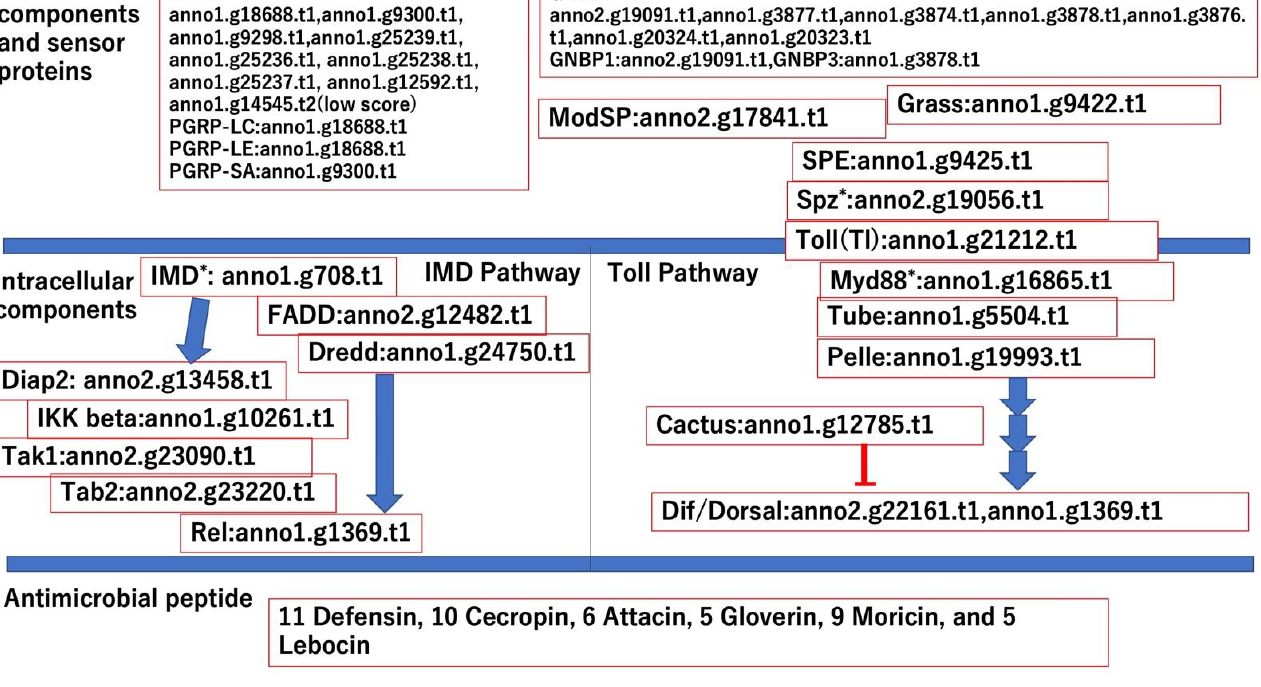
Figure 2. Gene IDs of the orthologues consisting of Toll and IMD pathway based on BLASTx search. The number of genes of antimicrobial peptides is shown in bottom of this figure, and the gene IDs of the orthologs of antimicrobial peptides are shown in Supplemental Data S10. Asterisks indicate that the orthologs were found by BLASTp search.